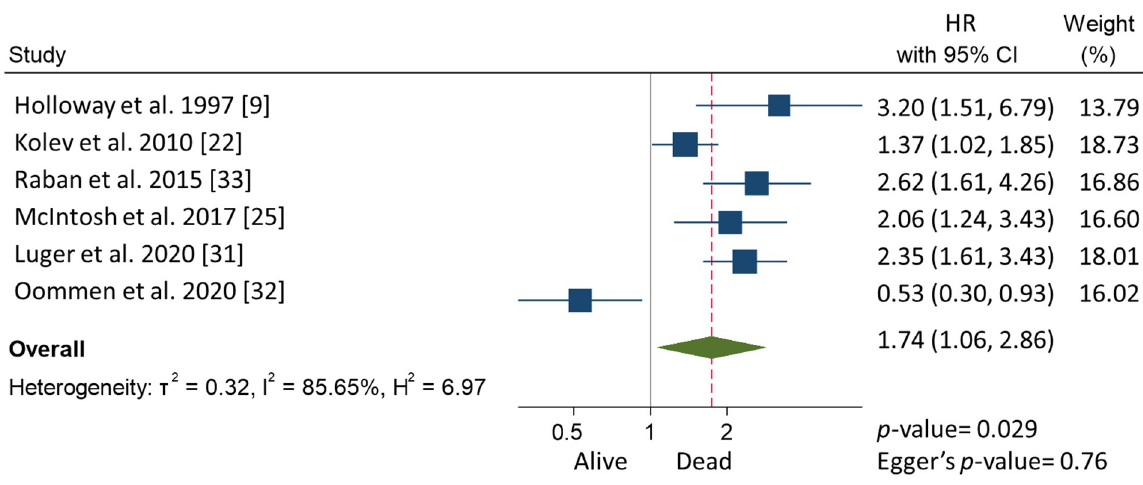
Figure 1. Forest plot displaying hazard ratios for mortality at 5 years in patients with CPLN adenopathy relative to those with no adenopathy.